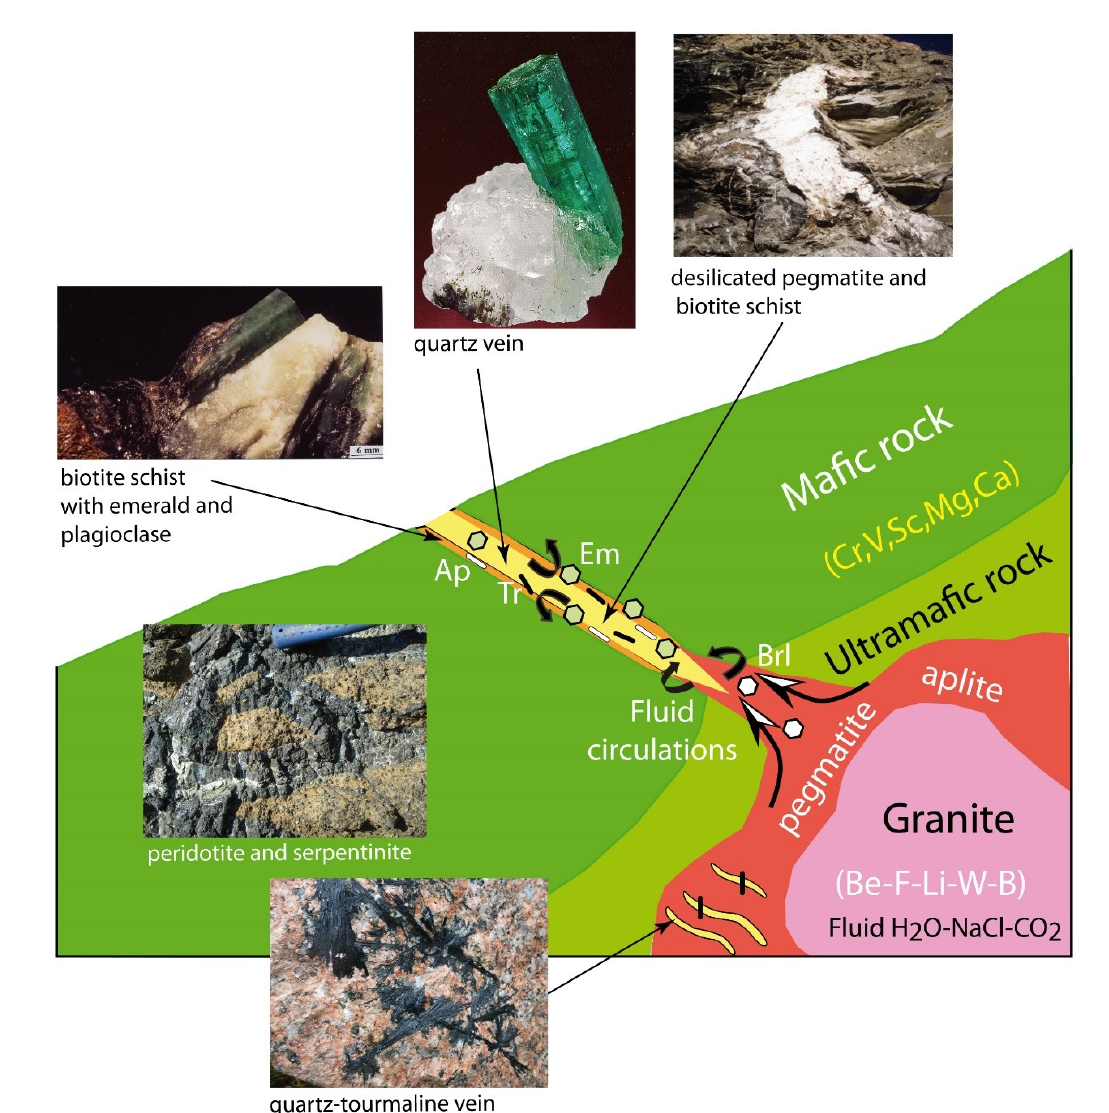
Figure 12. Idealized model for the Tectonic magmatic-related emerald type.The model is based on the emplacement in the crust of a granitic massif, with its pegmatite and aplite dikes and their tourmaline- (Tr) or beryl- (Brl) bearing quartz veins, intruding mafic (metabasalt) and/or ultramafic rocks (metaperidotite, serpentinite). The fluid circulations from the granite into the surrounding rocks and granitic dykes (arrows), preferentially along the contacts between the pegmatite or aplite or quartz veins and the regional rocks, transform the mafic rocks into a magnesium-rich biotite schist and the pegmatite into an albite-rich plagioclasite. Emerald (Em) and apatite (Ap) precipitates in the rocks affected by the fluid/rock interaction. It can precipitate in the pegmatite, aplite, plagioclasite, and quartz veins and their adjacent phlogopite schist